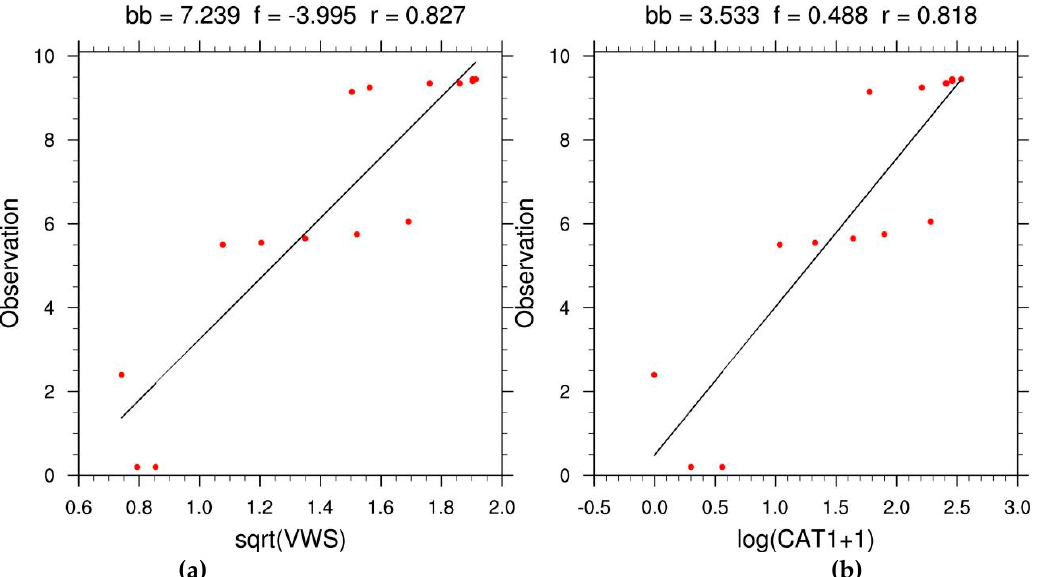
Figure 6. Quantiles of observations and ( a ) SQRT(VWS) and ( b ) log(CAT1 + 1). The scatters corre- spond to quantiles (25 and 50 for null turbulence; 50 for LGT; 50, 75, 80, 90, and 95 for MOD and SEV turbulence). The Pearson correlation (𝑟 ) is also indicated.